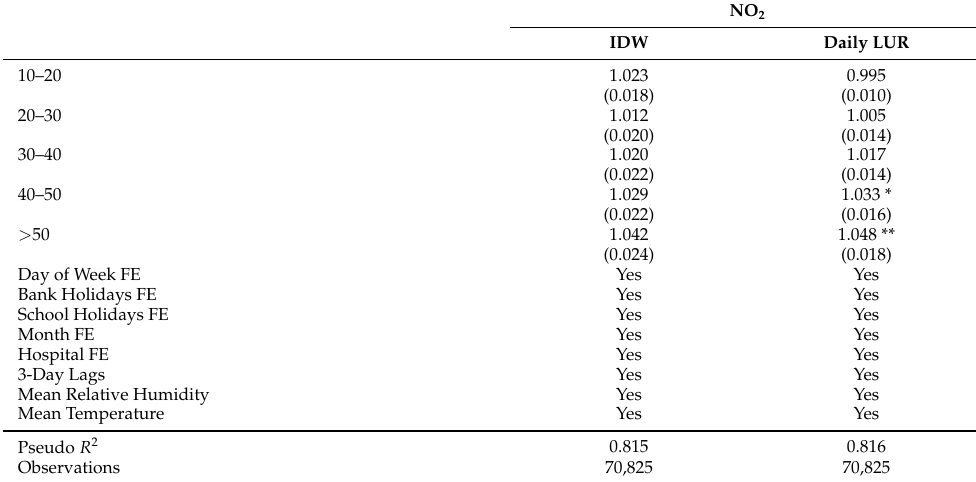
Exponentiated coefficients representing IRR. Robust S.E. clustered by NHS hospital in parentheses. * p < 0.05, ** p <